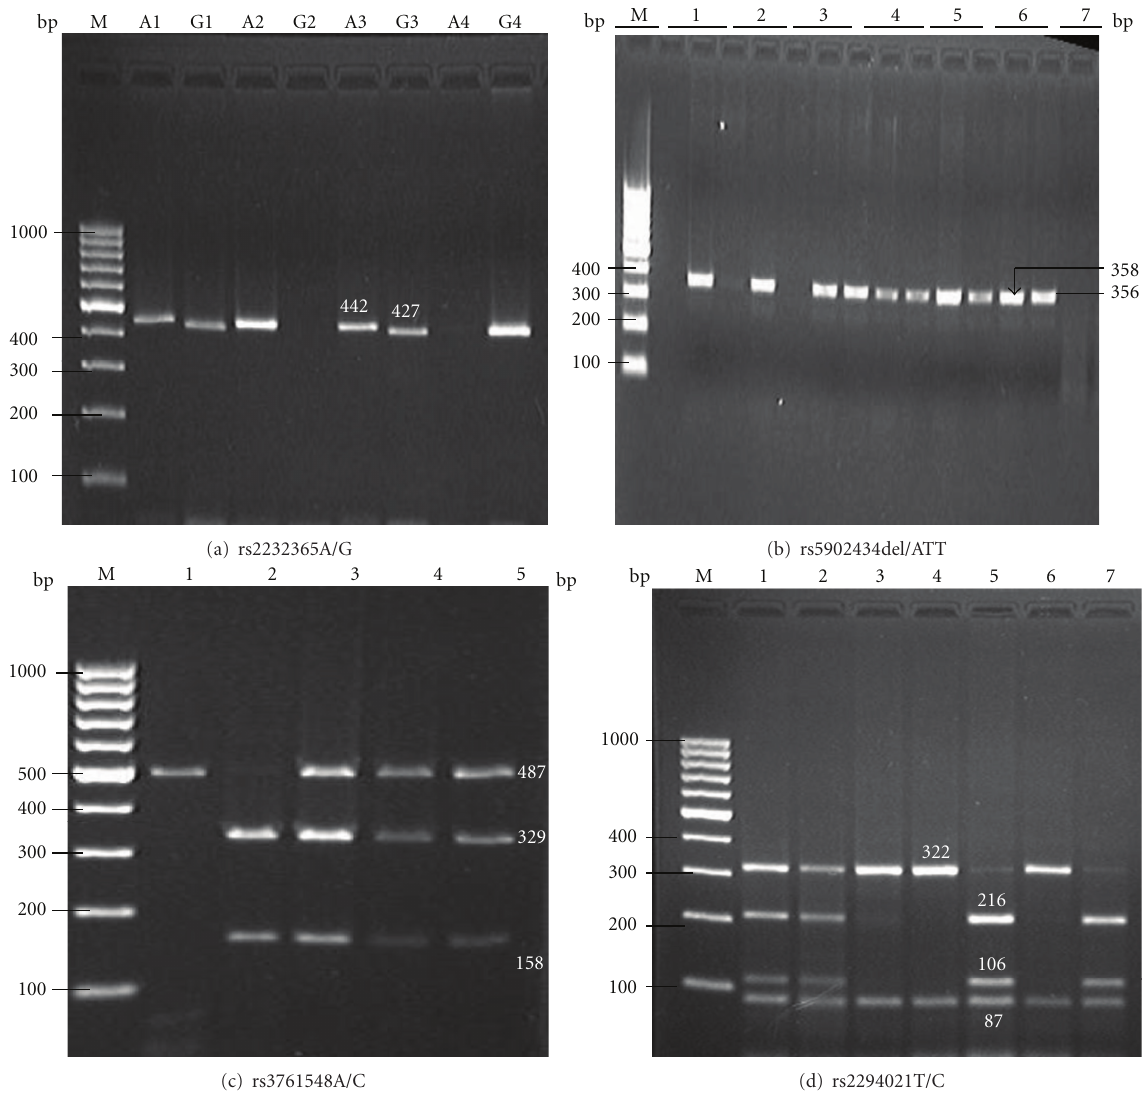
Figure 1: Typical band patterns of PCR-SSP or PCR-RFLP products. (a) is the band pattern for rs2232365. Lane 1 and 3 indicated A/G genotype; Lane 2 indicated A/A genotype; Lane 4 indicated G/G genotype. (b) is the band pattern for rs5902434. Lane 1, 2, and 3 indicated ATT/ATT genotype; Lane 4, 5, and 6 indicated del/ATT genotype; Lane 7 indicated del/del genotype. (c) is the band pattern for rs3761548. Lane 1 indicated A/A genotype; Lane 2 indicated C/C genotype; Lane 3, 4, and 5 indicated A/C genotype. (d) is the band pattern for rs2294021. Lane 1, 2 indicated T/C genotype; Lane 3, 4, and 6 indicated C/C genotype; Lane 5, 7 indicated T/T genotype. M represented 100bp DNA